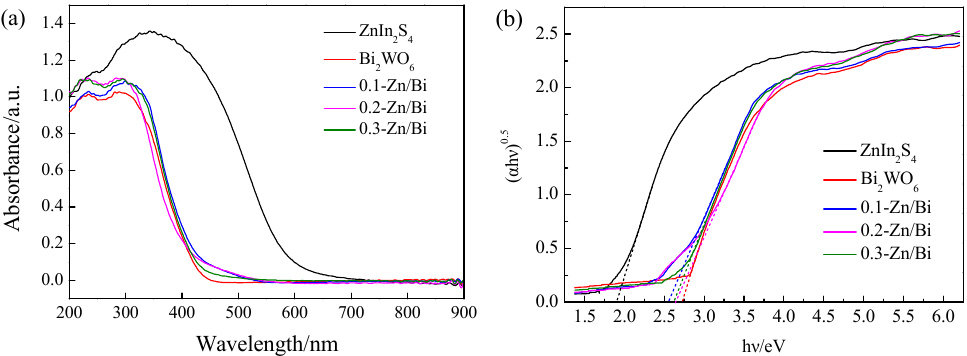
Figure 3. Optical properties of as-prepared photocatalyst: ( a ) UV-Vis diffuse reflectance spectras; ( b ) plots of ( α h ν ) 0.5 versus photon energy h ν .